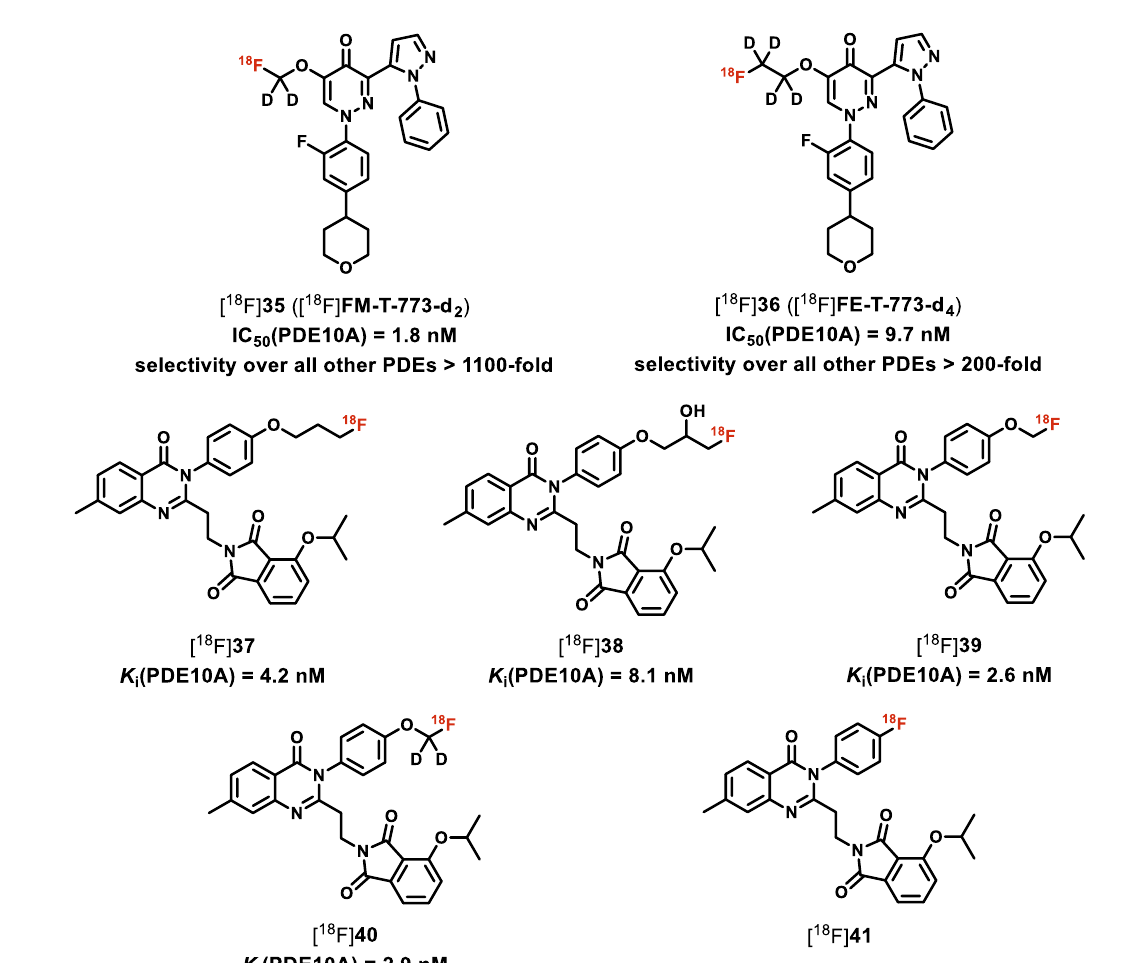
Figure 7. Molecular structures and IC 50 or K i values for PDE10A of ([ 18 F]) 35 and ([ 18 F]) 36 [177], ([ 18 F]) 37 , ([ 18 F]) 38 , ([ 18 F]) 39 and ([ 18 F]) 40 [123], and ([ 18 F]) 41 [178].